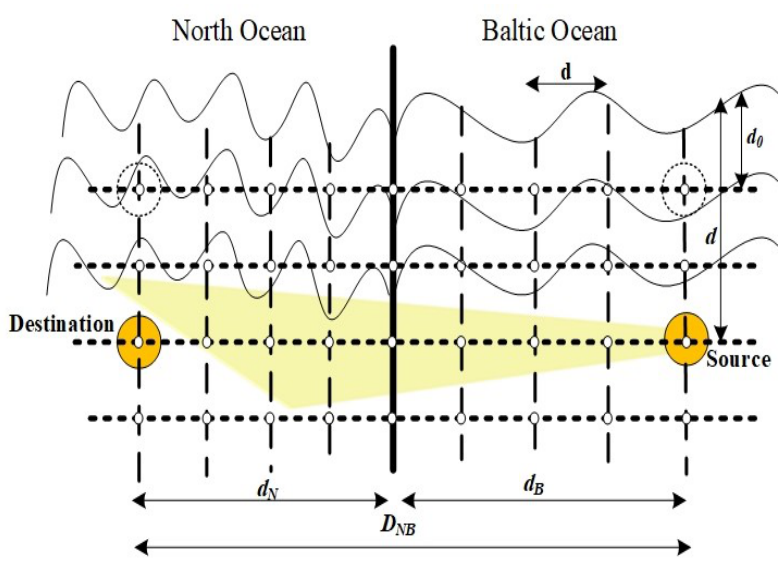
Figure 2. The proposed UVLC system model, where a source in Baltic sea propagates the signal through optical beam towards to the receiver based in North ocean. The investigate communication scenario is considered in strong channel